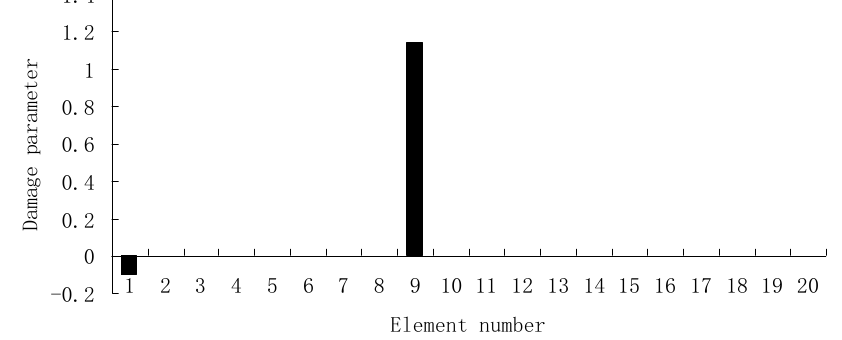
-0.2 Figure 25. Damage evaluation result by the fourth computation of ESVT for the experimental beam. Figure 25. Damage evaluation result by the fourth computation of ESVT for the experimental beam. Figure 25. Damage evaluation result by the fourth computation of ESVT for the experimental beam. Figure 25. Damage evaluation result by the fourth computation of ESVT for the experimental beam.